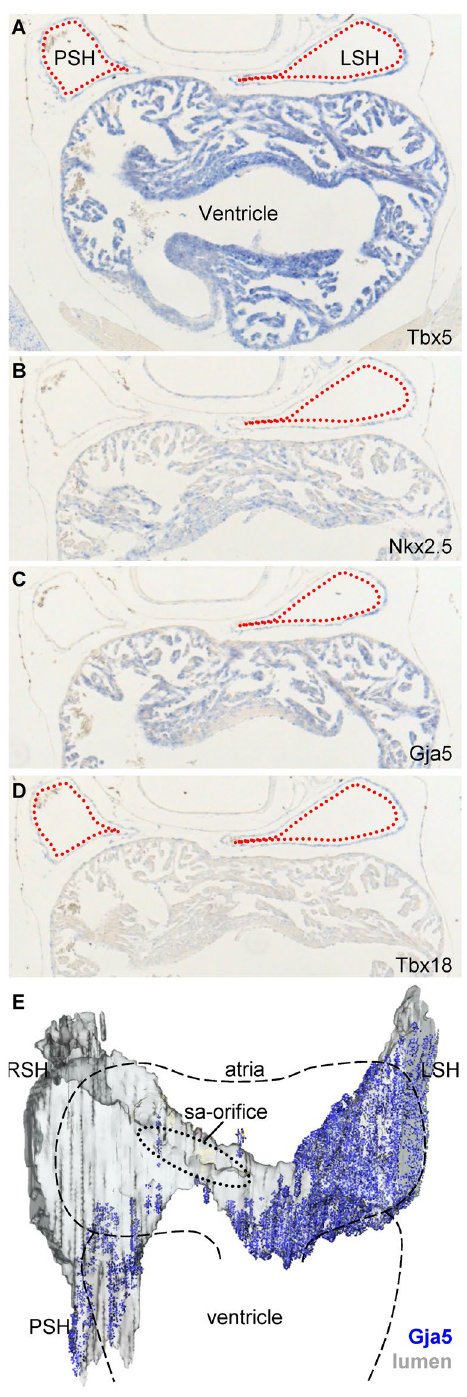
Figure 5. Distal parts of the sinus venosus of Anolis sagrei have the molecular phenotype of a chamber. ( A , B ) Tbx5 is expressed in the entire sinus venosus myocardium ( A ), whereas Nkx2.5 is expressed in the distal parts only ( B ). ( C ) Expression of Gja5 co-localizes with Nkx2.5 . ( D ) The sinus myocardium is distinct from the atria and ventricle by expressing Tbx18 . ( E ) Overview of Gja5 expression in a near-hatching Anolis sagrei . LSH, left sinus horn; PSH, posterior sinus horn; RSH, right sinus horn; sa, sinuatrial; V,